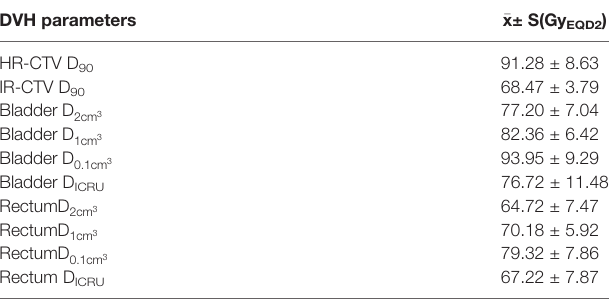
TABLE 1 | DVH parameters for HR-CTV and OARs.